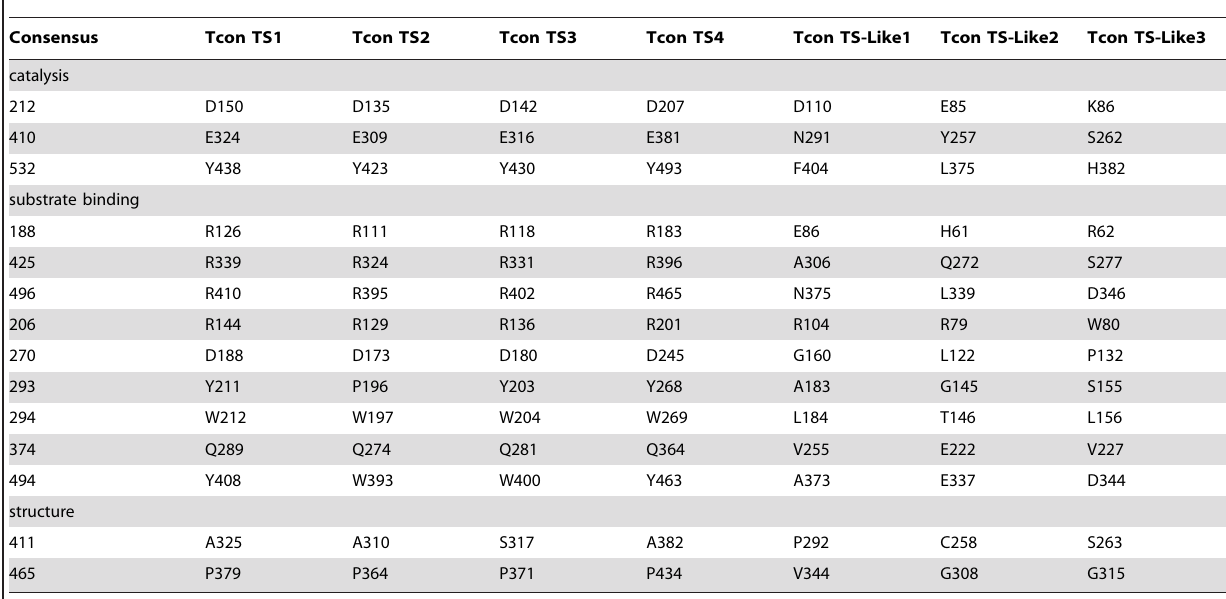
Table 2. Amino acids in the catalytic domains of TS and TS-Like genes from T. congolense involved in enzymatic activities*.